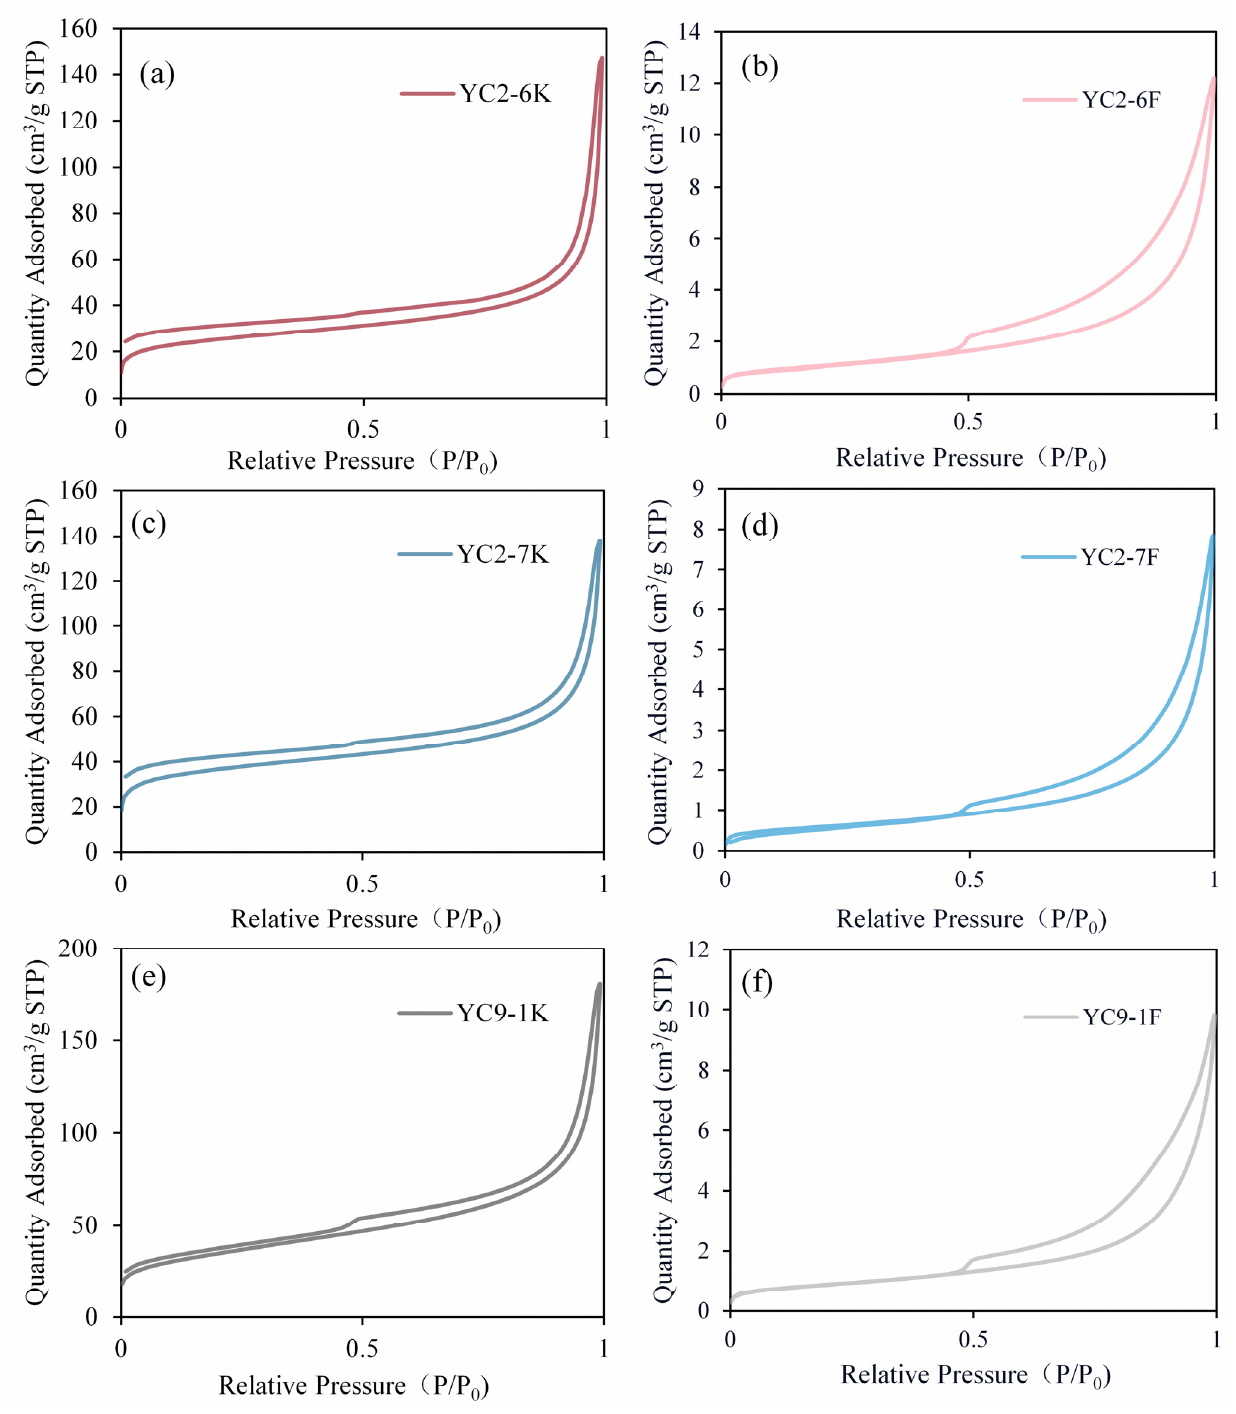
Figure 15. LPNA curves for isolated kerogen ( a , c , e ) and OM-oxidized ( b , d , f ) samples. See details in text.